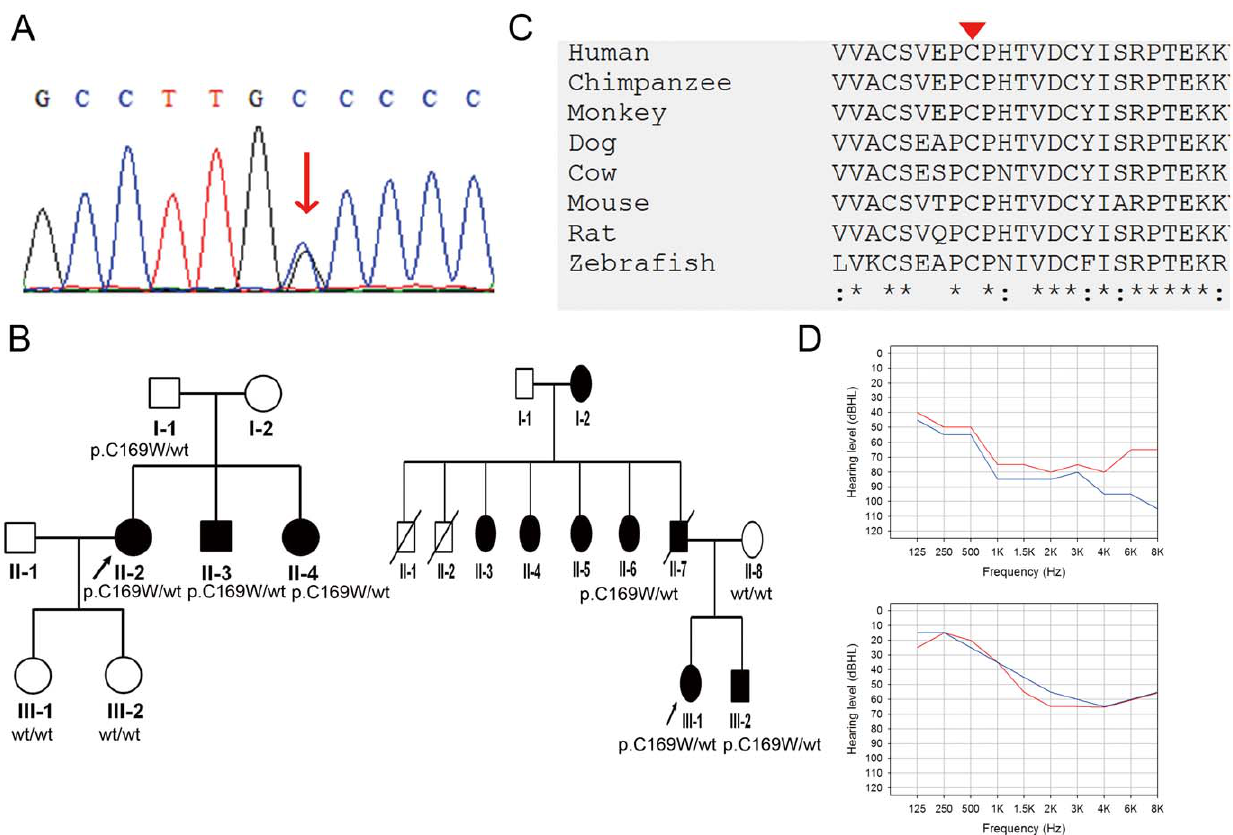
Figure 5. Probable non-causative GJB4 p.C169W variant identified in Family DE2827 and Family DE3281. (A) Sanger sequence of the GJB4 p.C169W variant. Arrow: nucleotide change c.507C . G (p.C169W) variant. (B) Pedigree and segregation patterns of Family DE2827 and Family DE3281. (C) Evolutionary conservation of the p.C169 residue. Arrowhead: variant site. (D) Audiograms of the probands of Family DE2827 (upper panel) and Family DE3281 (lower panel). Hearing levels of the right ear and left ear are marked with red and blue lines,